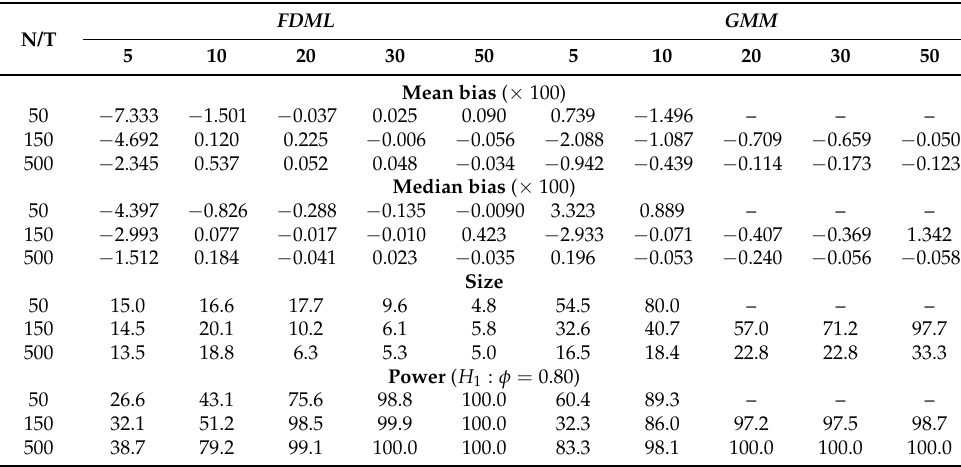
Table 1. Mean bias, median bias, size and power for φ =